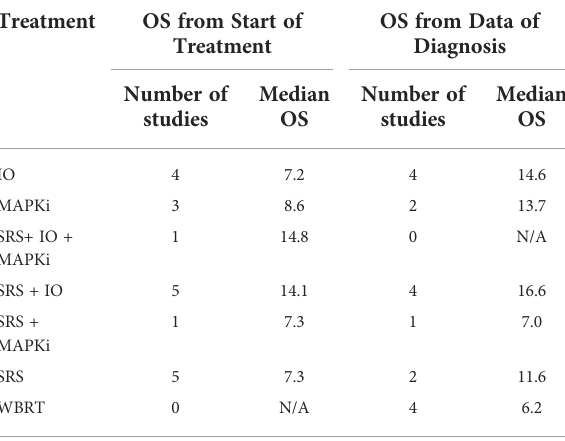
TABLE 1 Weighted average median overall survival (OS) in months by treatment.